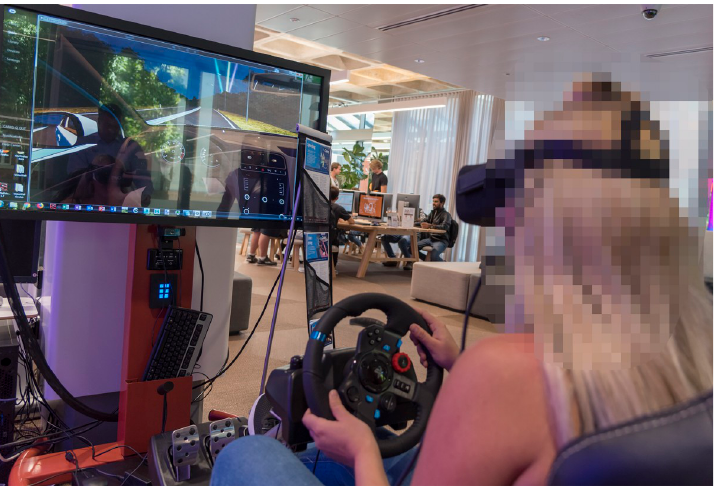
Fig 3. A participant is getting used to managing the VR driving